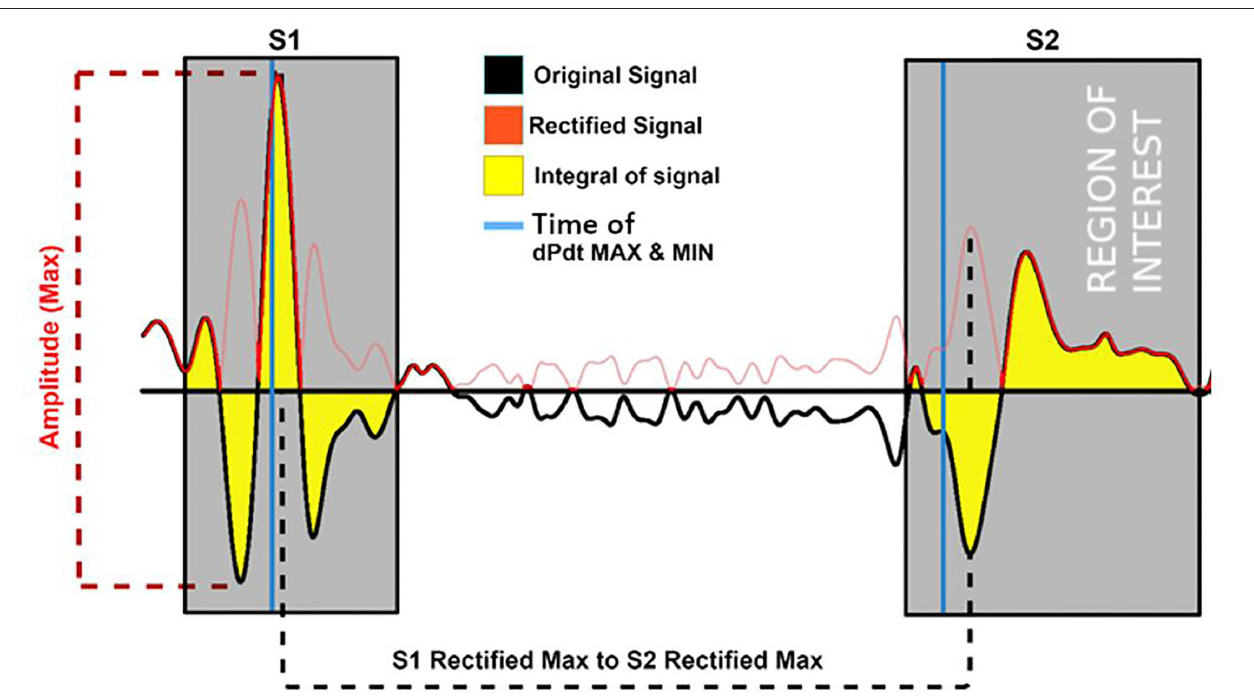
FIGURE 2 | Examples of the training features extracted from the accelerations signal (black) and its rectified version (red). Features depicted are the maximum amplitude of the signal; its integral and the location time duration between the rectified S1 and S2 maximum of the rectified (negative and positive as positive) signals. Gray area = region of feature